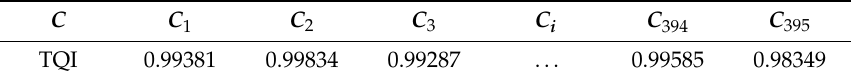
Table 13. TQI of each high-speed track section evaluated (unit: